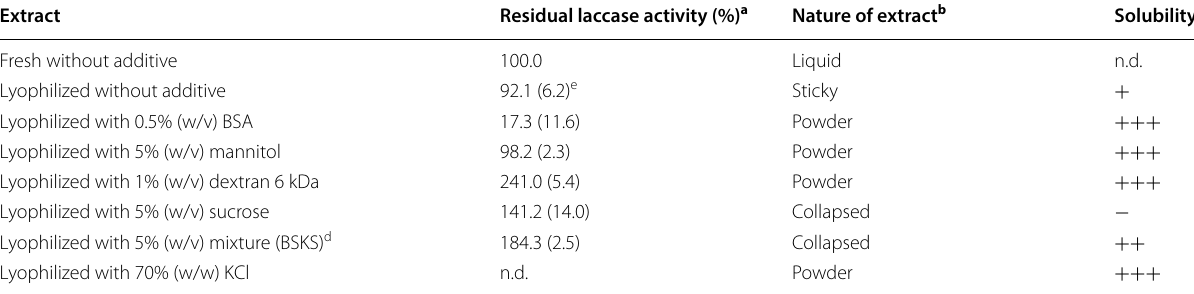
n.d. Not detected a Residual laccase activity (%) was defined as the specific activity (nmol product/mg protein/min) of the lyophilized trial in comparison to that of the fresh ultrafiltrated enzymatic extract before lyophilization without additive b Nature of the extract was defined as the final texture of the lyophilized enzymatic c